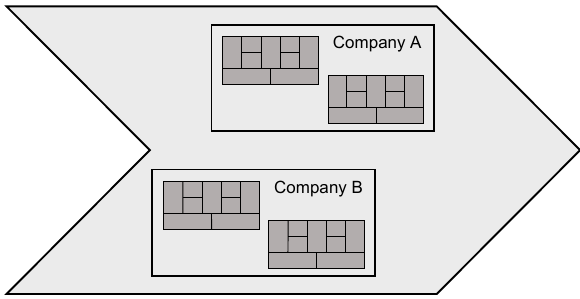
Figure 3. Business models as embedded cases in one company based on the design options for case studies by Yin (2013) [29].